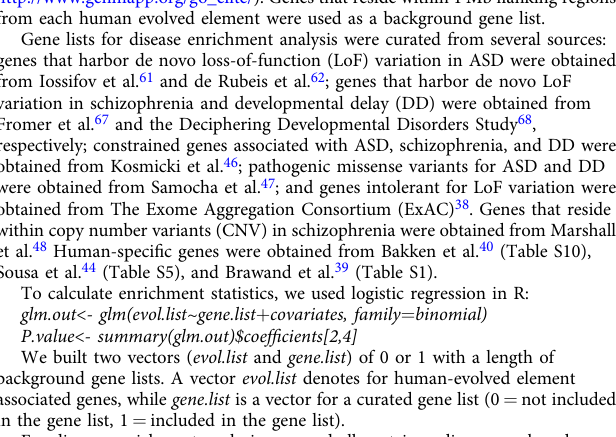
Table 2 Annotations for chromatin states